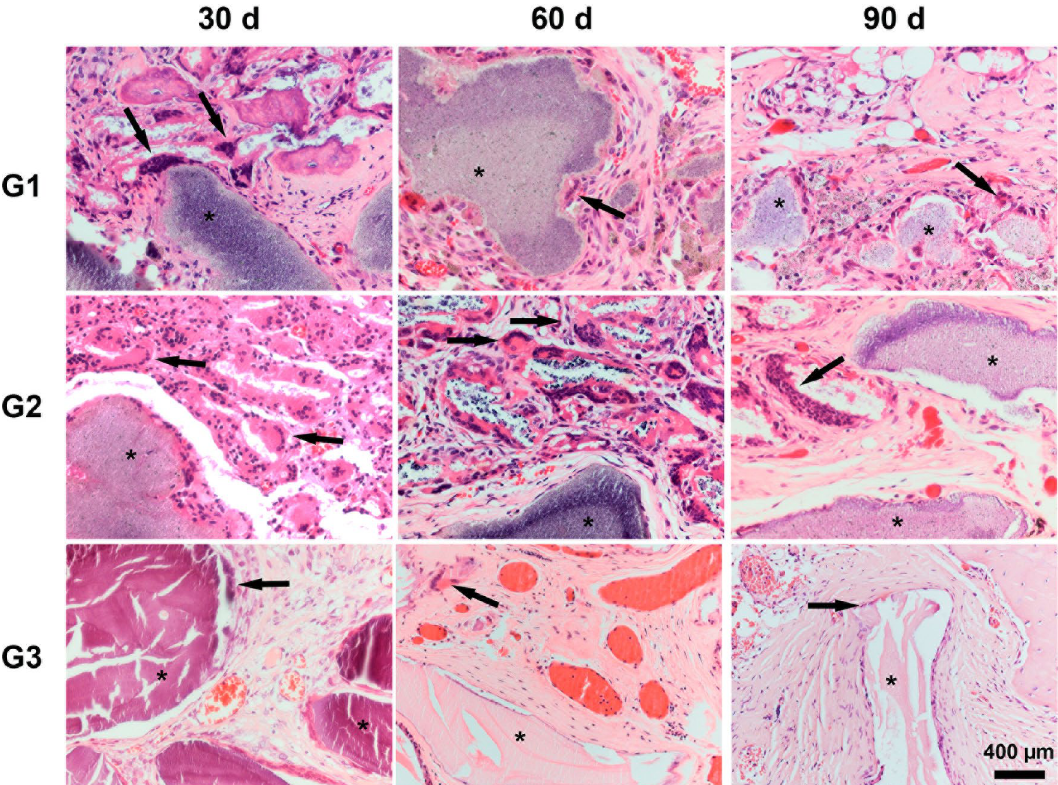
Figure 3. Histological images stained with hematoxylin and eosin from the areas of critical-sized bone defects filled with biphasic materials G1 (Nanosynt 250 to 500 μm), G2 (Nanosynt 500 to 1000 μm), and xenogeneic G3 (Bio-Oss 200 to 1000 μm) at 30, 60 and 90 days. Detailed images showing the presence of remaining biomaterials (*) and foreign body multinucleated giant cells ( → ) within the implantation bed. Bar = 400